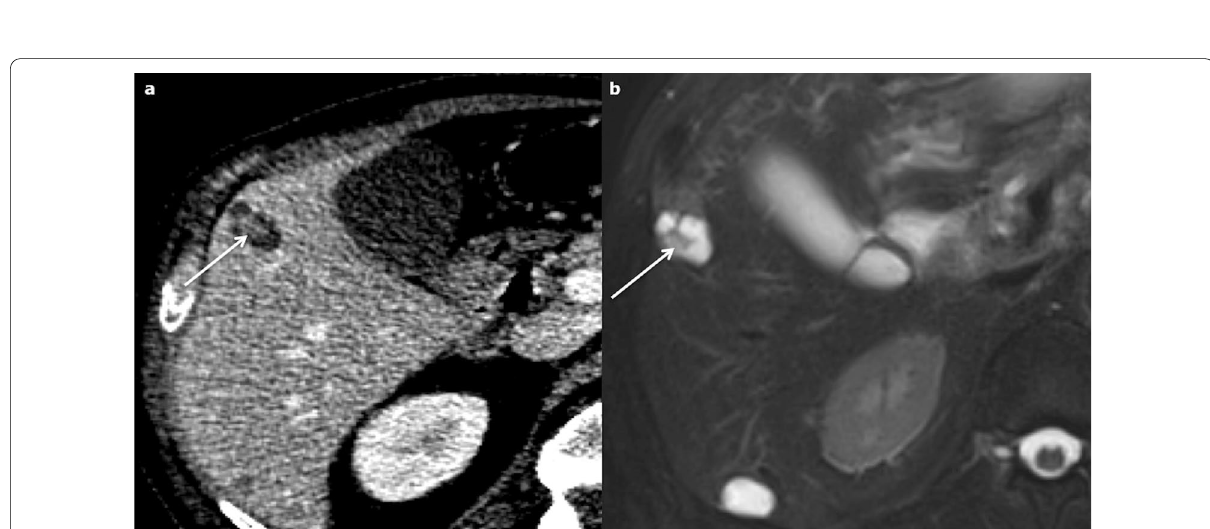
Fig. 23 Metastatic pancreatic neuroendocrine tumour in a 60-year-old male. a Axial computed tomography on portal venous phase shows a lobulated hypodense cystic nodule in segment V with enhanced mural nodule and septa (arrow), very hyperintense on T2-weighted magnetic resonance imaging ( b ). A second cystic subcapsular nodule is visible in segment